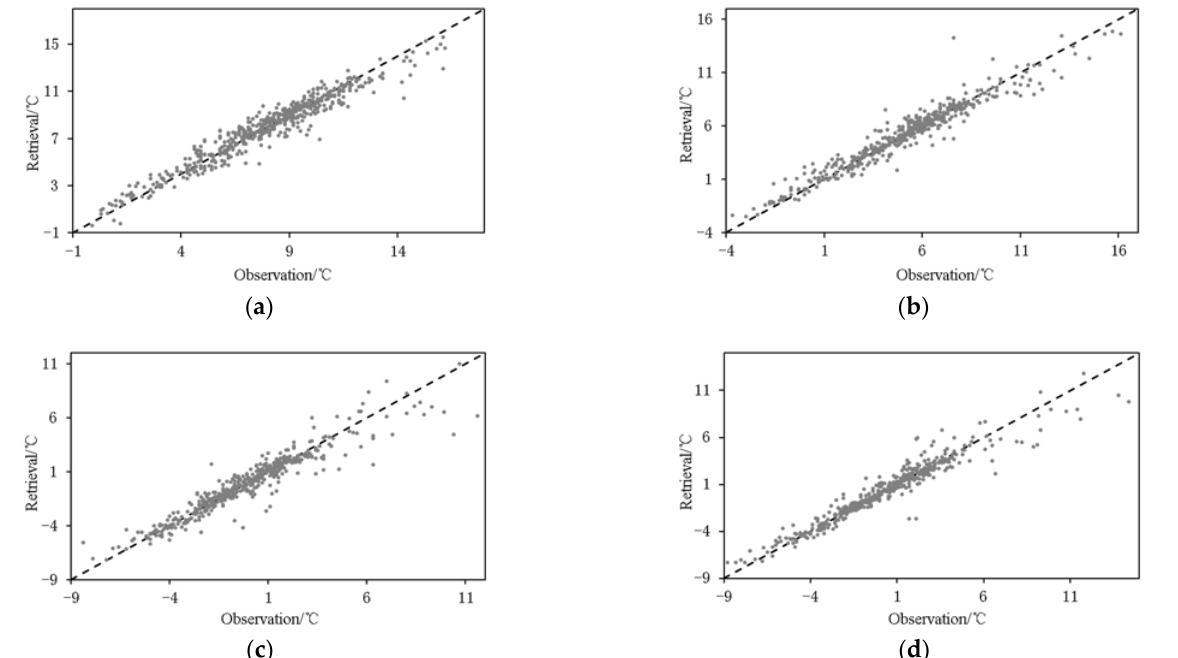
Figure 9. Scatter plot for observations and retrievals of road surface (bridge deck) temperature using the random forest model at road surface station 1 ( a ), road surface station 2 ( b ), bridge deck station 1 ( c ), and bridge deck station 2 ( d ).